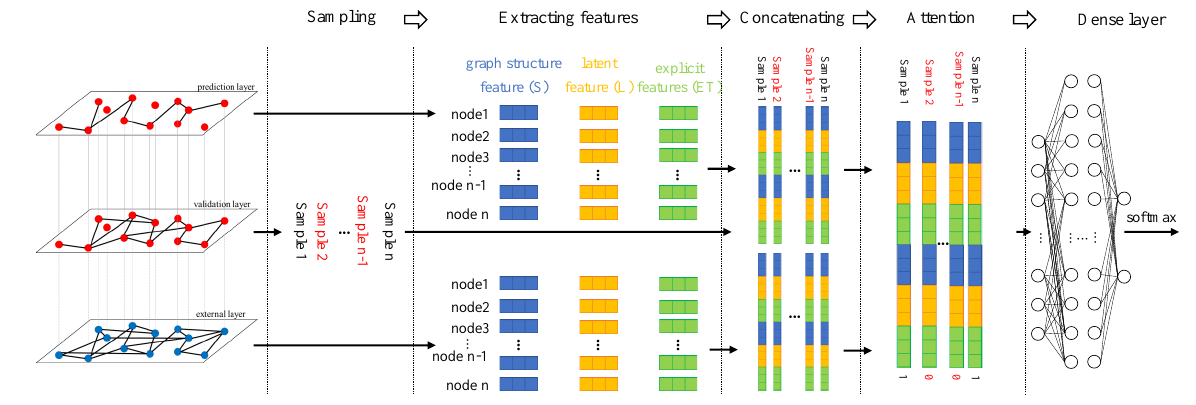
Figure 3. Overall framework of LPSMN. The overall framework includes 5 steps. The first step is sampling on the validation layer, and the next step is extracting three types of features from the external layer and the prediction layer, respectively. Then, sample representations are generated by concatenating the features of each node. The fourth step is using an attention mechanism to fuse the sample representation from the external and prediction layers. Finally, we use a dense layer to predict the label of the